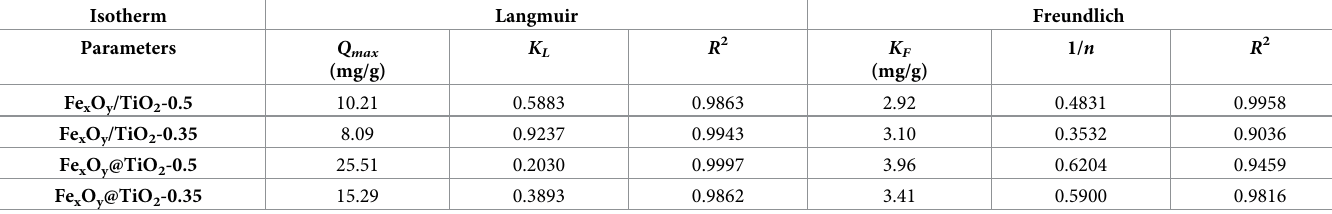
Table 2. Parameters of Q max and K L in Langmuir isotherm and K F and 1/ n in Freundlich isotherm. Isotherm Langmuir Freundlich Parameters Fe x O y /TiO 2 -0.5 Fe x O y /TiO 2